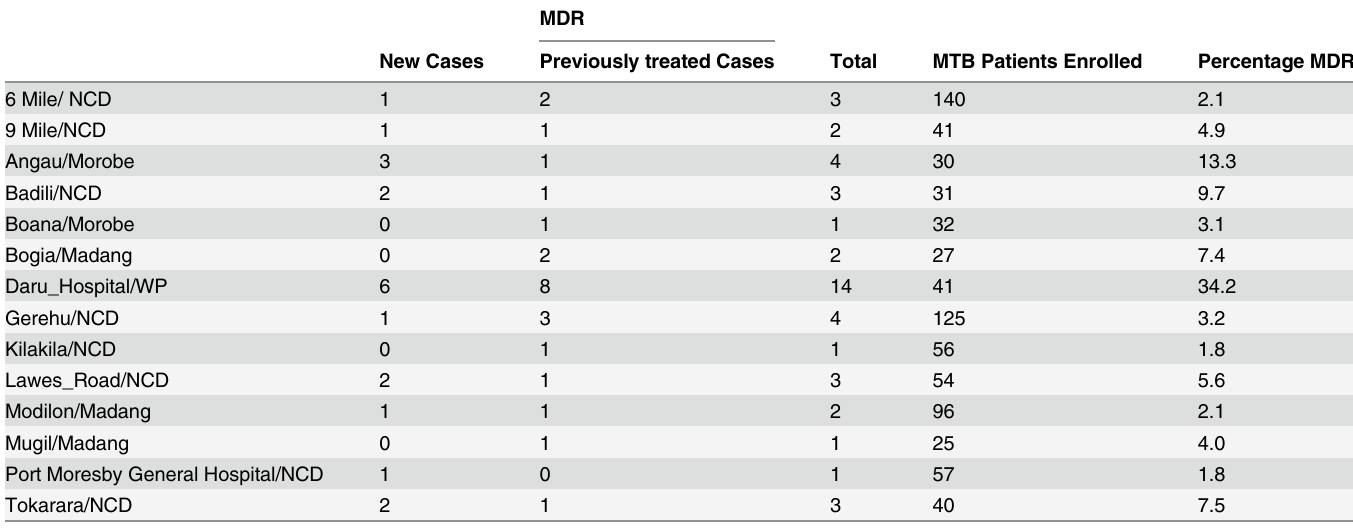
Table 3. Distribution of MDR Cases across Diagnostic Centres (where at least 1 MDR-TB case was